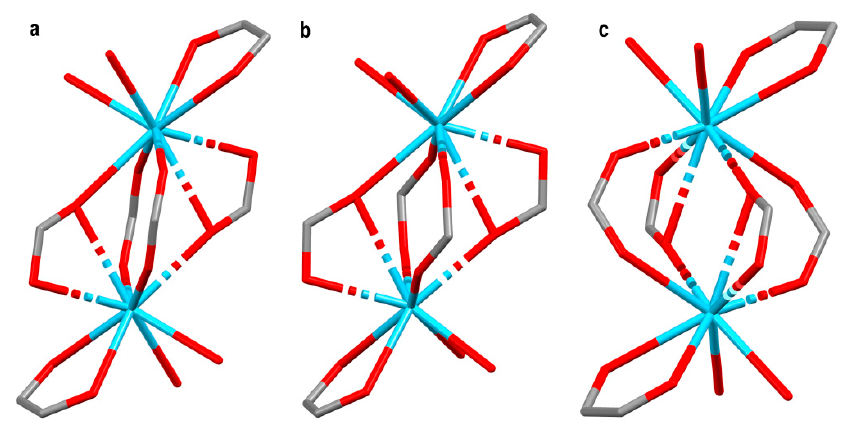
Figure 3. The core of the binuclear units of 1 ( a ), 2 ( b ) and 3 ( c ). Color code: La, light blue; C, gray; O, red.